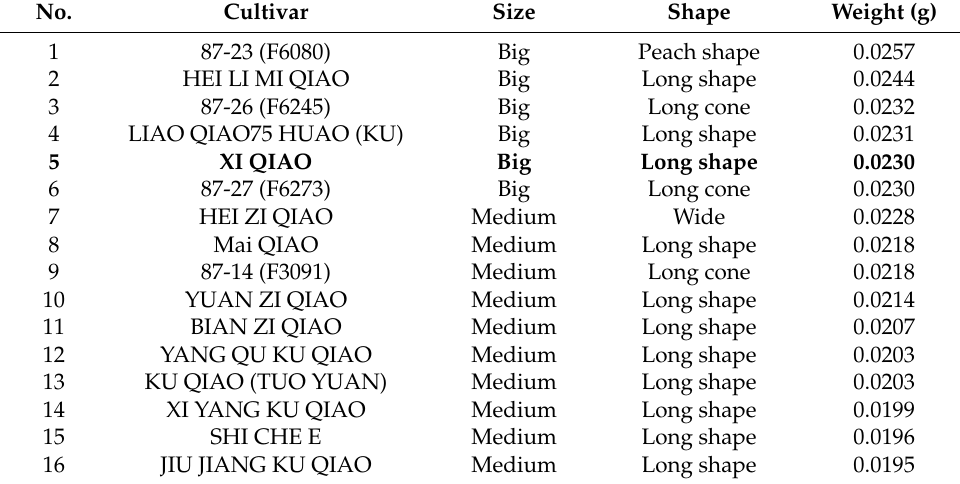
Table 4. Mature fruit size, shape, and weight of the different accessions from Fagopyrum tataricum .